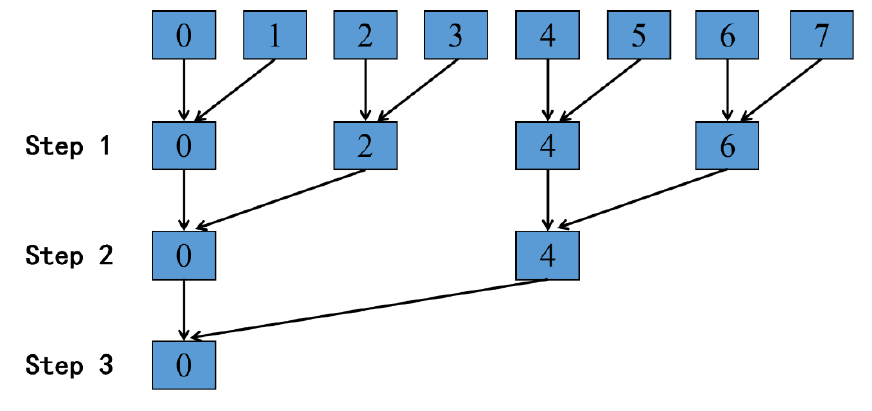
Figure 7. Register communication.